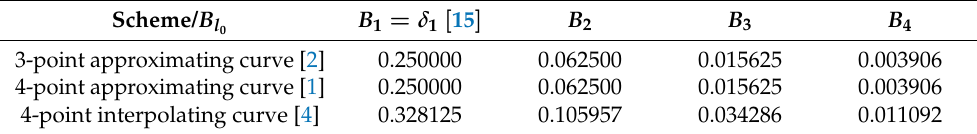
for l 0 = 1,2,3,4. 0